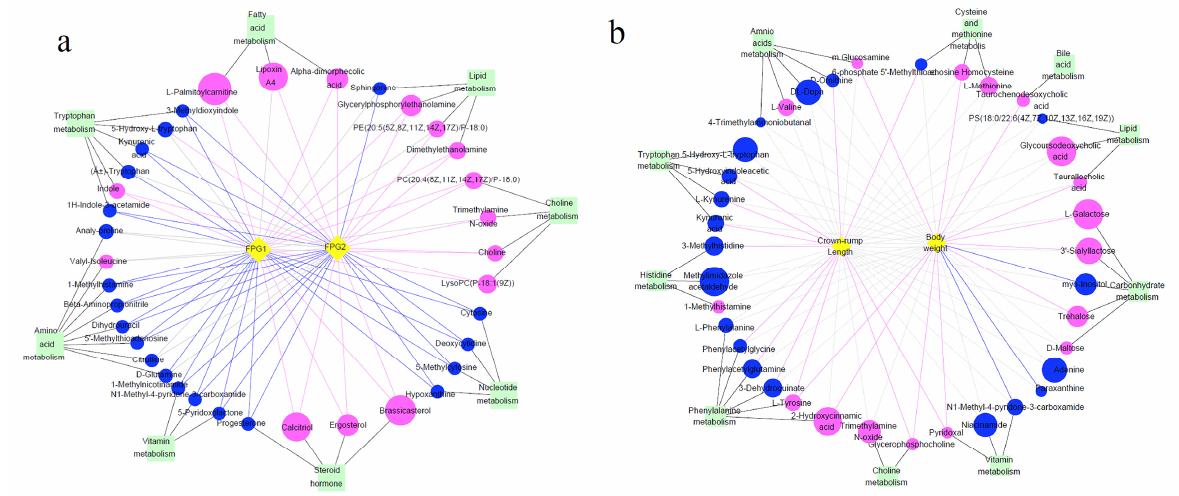
Figure 5. The co-occurrence network of differential metabolites and their maternal–fetal repercussions. The circles: differential metabolites; the diamonds: maternal FPG or fetal body weight or crown–rump length; the squares: the metabolism pathways that metabolites participated in. The blue circles represent the downregulated metabolites compared to CON, and the red circles represent upregulated metabolites. The size of circles means the VIP. Blue lines represent significantly negative associations between metabolites and maternal FPG or fetal body weight or crown–rump length, while the red lines represent significantly positive associations. Grey dotted lines represent no significant association. ( a ) The association of metabolites with maternal FPG during the second and third trimesters. ( b ) The association of metabolites with fetal body weight and crown–rump length. FPG1: fasting plasma glucose in the second trimester; FPG2: fasting plasma glucose in the third trimester.